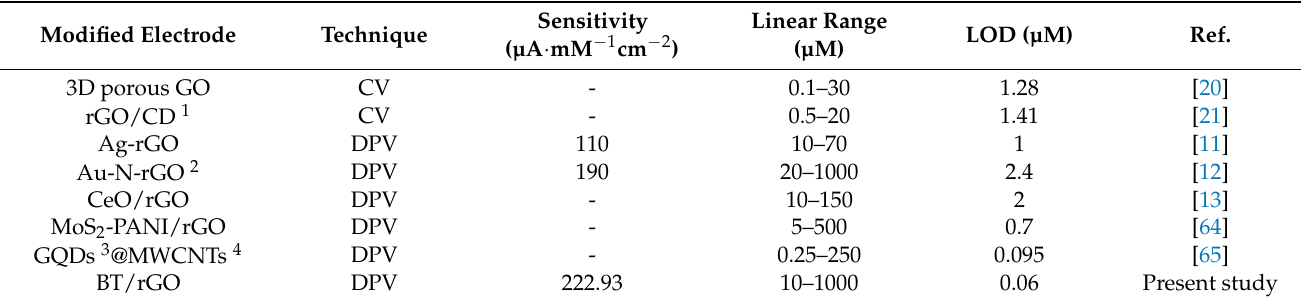
Table 1. Analytical parameters of dopamine oxidation at the BT/rGO electrode from this study compared with previously reported